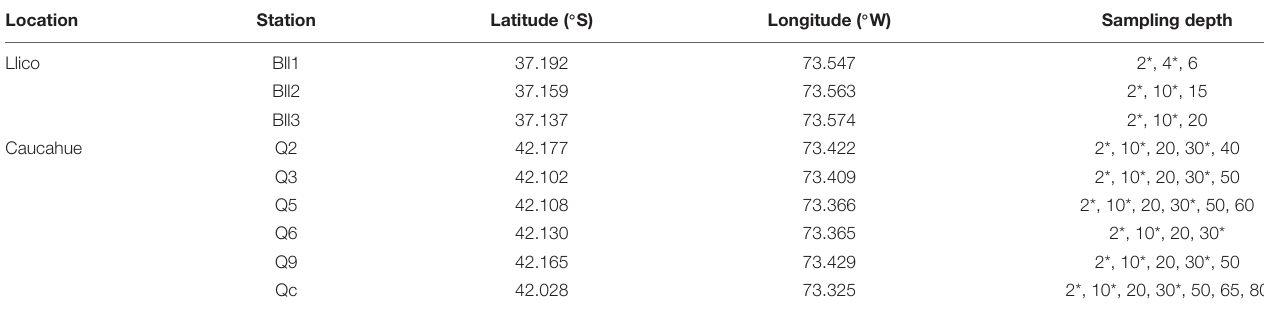
TABLE 1 | Geographical location and seawater sampling depths for hydrographic characterization at Llico Bay and Caucahue channel stations. Location Station Latitude ( ◦ S) Longitude ( ◦